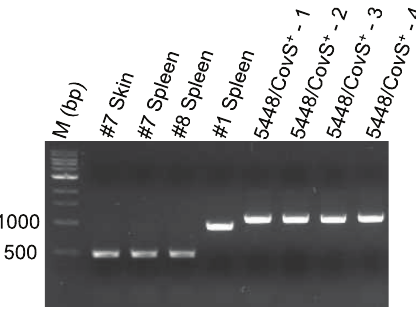
Figure 2. PCR of GAS 5448/covR + S + inoculum prior to infection. Primers specific for regions of the covS gene that did not undergo mutations, but whose products would reveal the presence of a mutation, were used for PCR analysis. Genomic DNA isolated from overnight cultures of four different colonies of 5448/CovR + S + was tested to determine if any mutations were present prior to injection. Mutant strains identified in this study were used as controls in lanes 2–5.